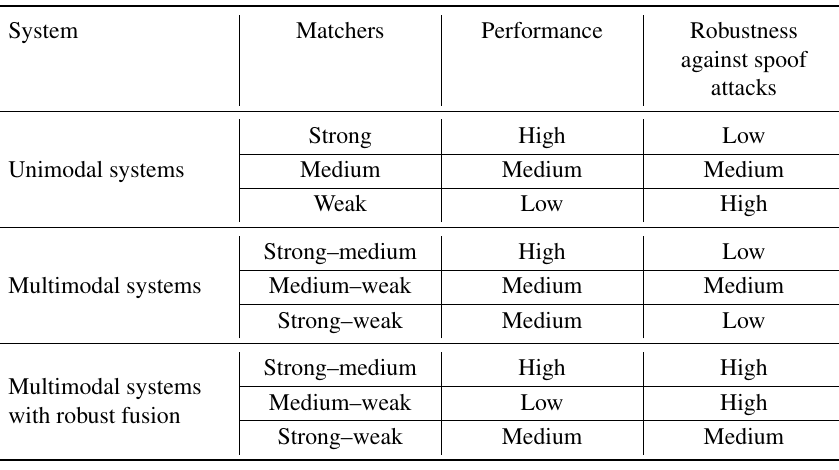
Table 8. Trade-off between performance and robustness against spoof attacks in biometric systems. using FAR and SFAR operating points, the FRRs are 0.03%, 7.73% and FARs are 67.25%, 4.99% (more accurate matcher (strong matcher) spoofing) and